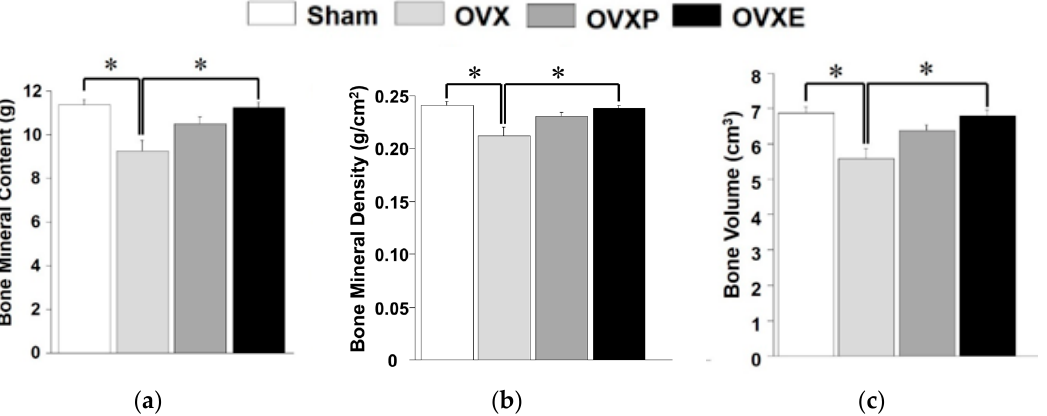
Figure 4. Analysis of dual-energy X-ray absorption for the whole body. ( a ) Bone mineral contents (BMC), ( b ) bone mineral density (BMD), and ( c ) bone volume (BV). * p < 0.05.